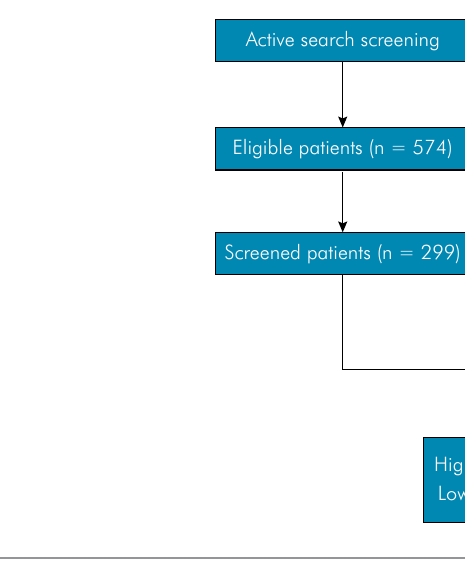
Figure. Profile of screening program arms, frequency of patients and group of patients.